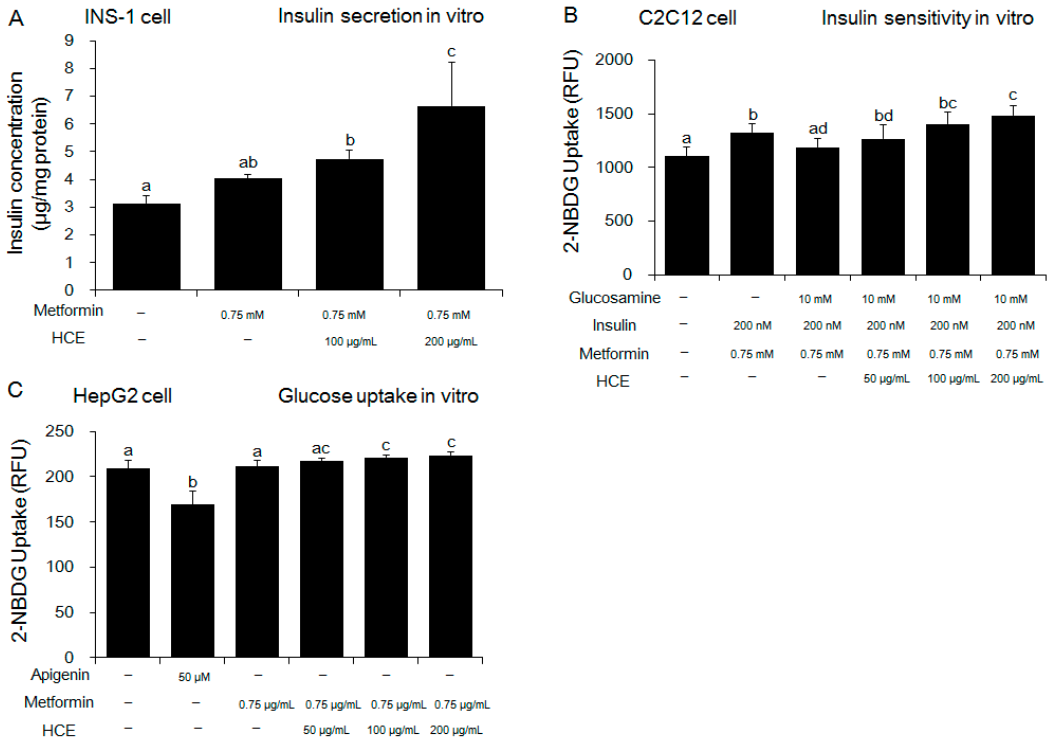
Figure 3. Effect of metformin either alone or in combination with HCE on the in vitro insulin secretion, insulin sensitivity, and glucose uptake. ( A ) Insulin secretion, ( B ) insulin sensitivity and ( C ) glucose uptake were measured using INS-1 (an insulin-secreting cell line), C2C12 (an immortalized mouse myoblast cell line), and HepG2 (a human liver cancer cell line) cells, respectively as mentioned in the Materials and Methods section. Data with different letters are significantly different ( p < 0.05) according to one way ANOVA analysis.